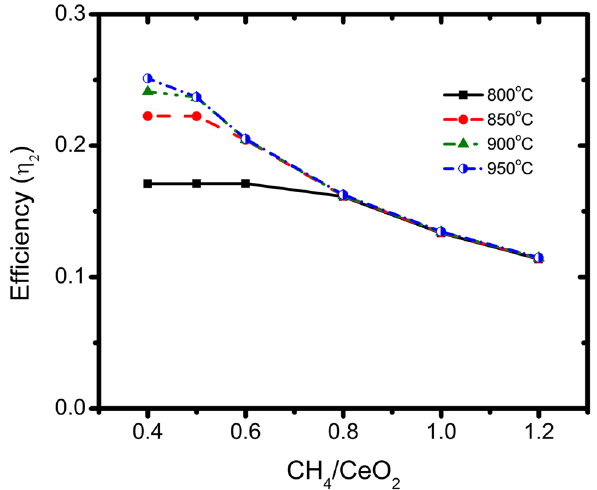
Fig. 11 Impact of the CH 4 /CeO 2 molar feed ratio and temperature, on the system efficiency considering only the yield from CO 2 and H 2 O splitting ( η 2 ), based on isothermal system operation and a constant flow of 1 kmol/h of waste gas at equimolar composition within the oxidation